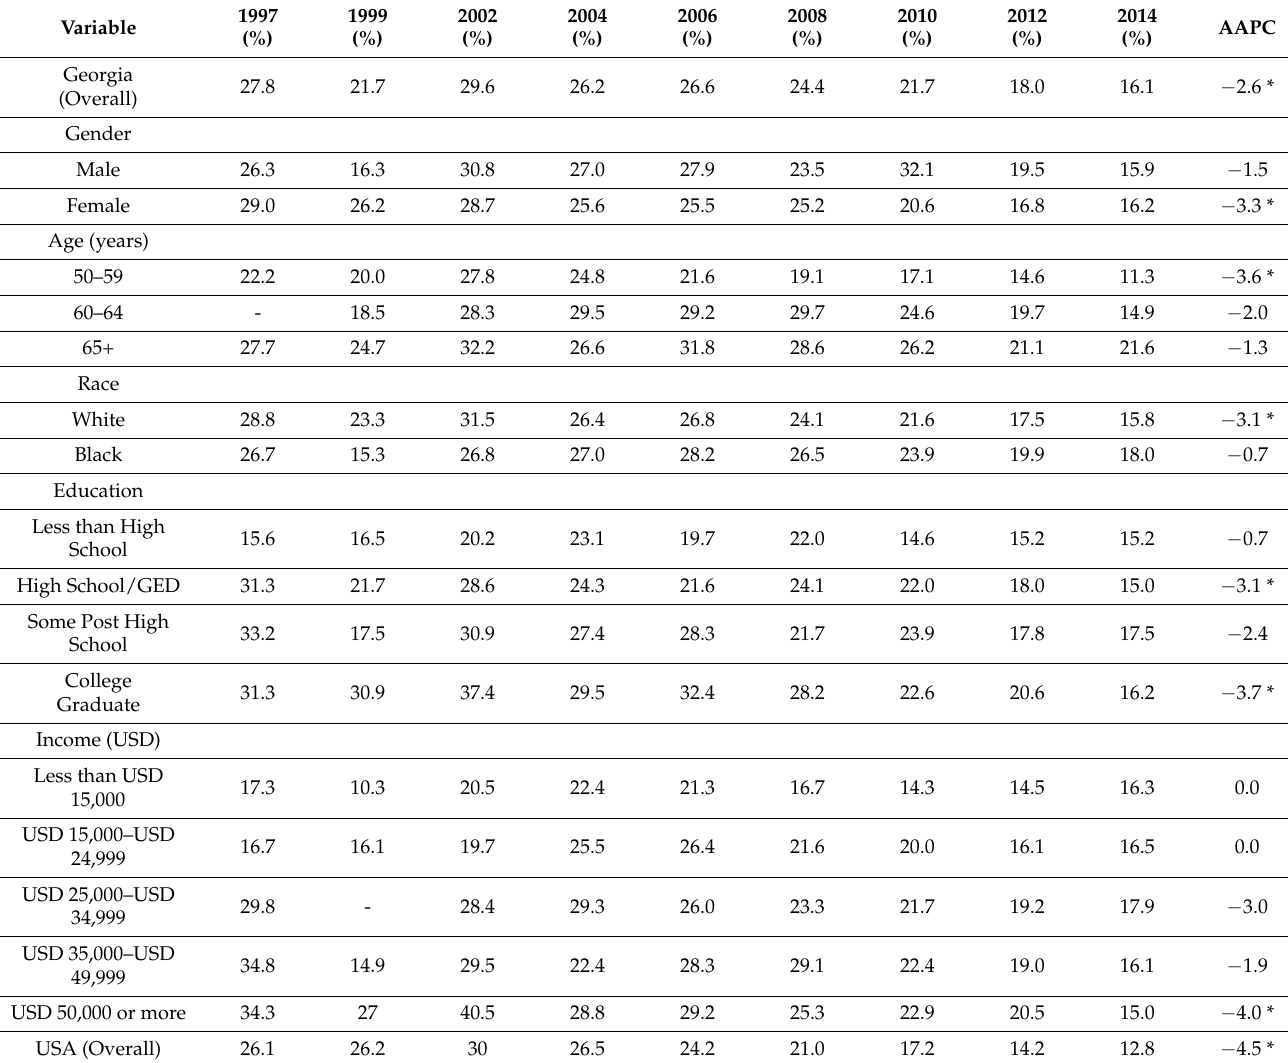
Table 1. Adults aged 50+ who have had a blood stool test within the past two years in Georgia: 1997–2014 BRFSS